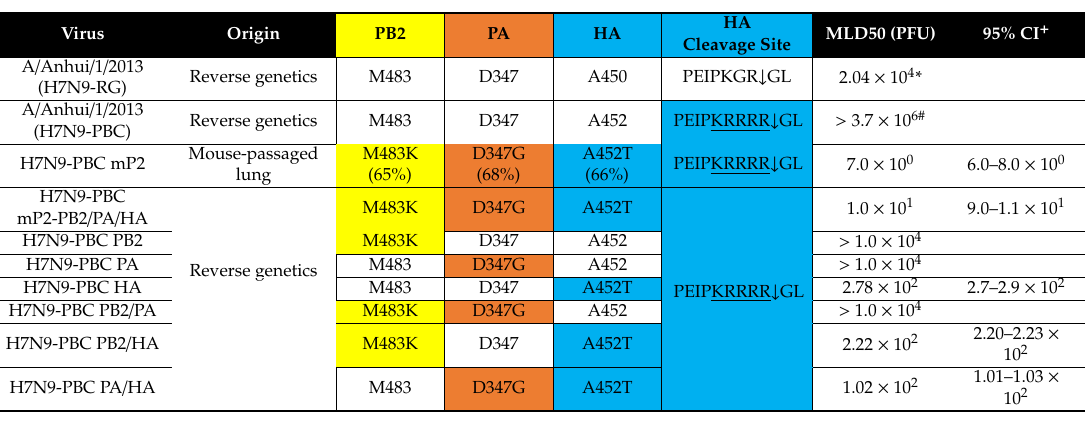
Table 1. Determinants of pathogenicity of mouse passaged H7N9-PBC. Next-generation sequencing results of H7N9-PBC viruses after two passages in mice identify amino acid mutations in PB2 (M483), PA (D347), and HA (A452, H7 numbering with signal peptide included) genes. Amino acid residues mutated are noted and the percent frequency of the mutation observed is shown. A complete reverse genetics engineered H7N9-PBC mP2 containing all three identified mutations was created (H7N9-PBC mP2-PB2 / PA / HA) along with H7N9-PBC viruses containing all possible combinations of the mutations found. The mouse median lethal dose (MLD 50 ) was determined for all viruses by infecting mice ( n = 6) starting at 1 × 10 4 PFU and subsequent 10-fold serial dilutions. For * and # , MLD 50 was determined previously starting with maximum dose possible based on viral stock titer. + MLD 50 was determined using the method of Miller and Tainter, 95% confidence interval (CI) values are